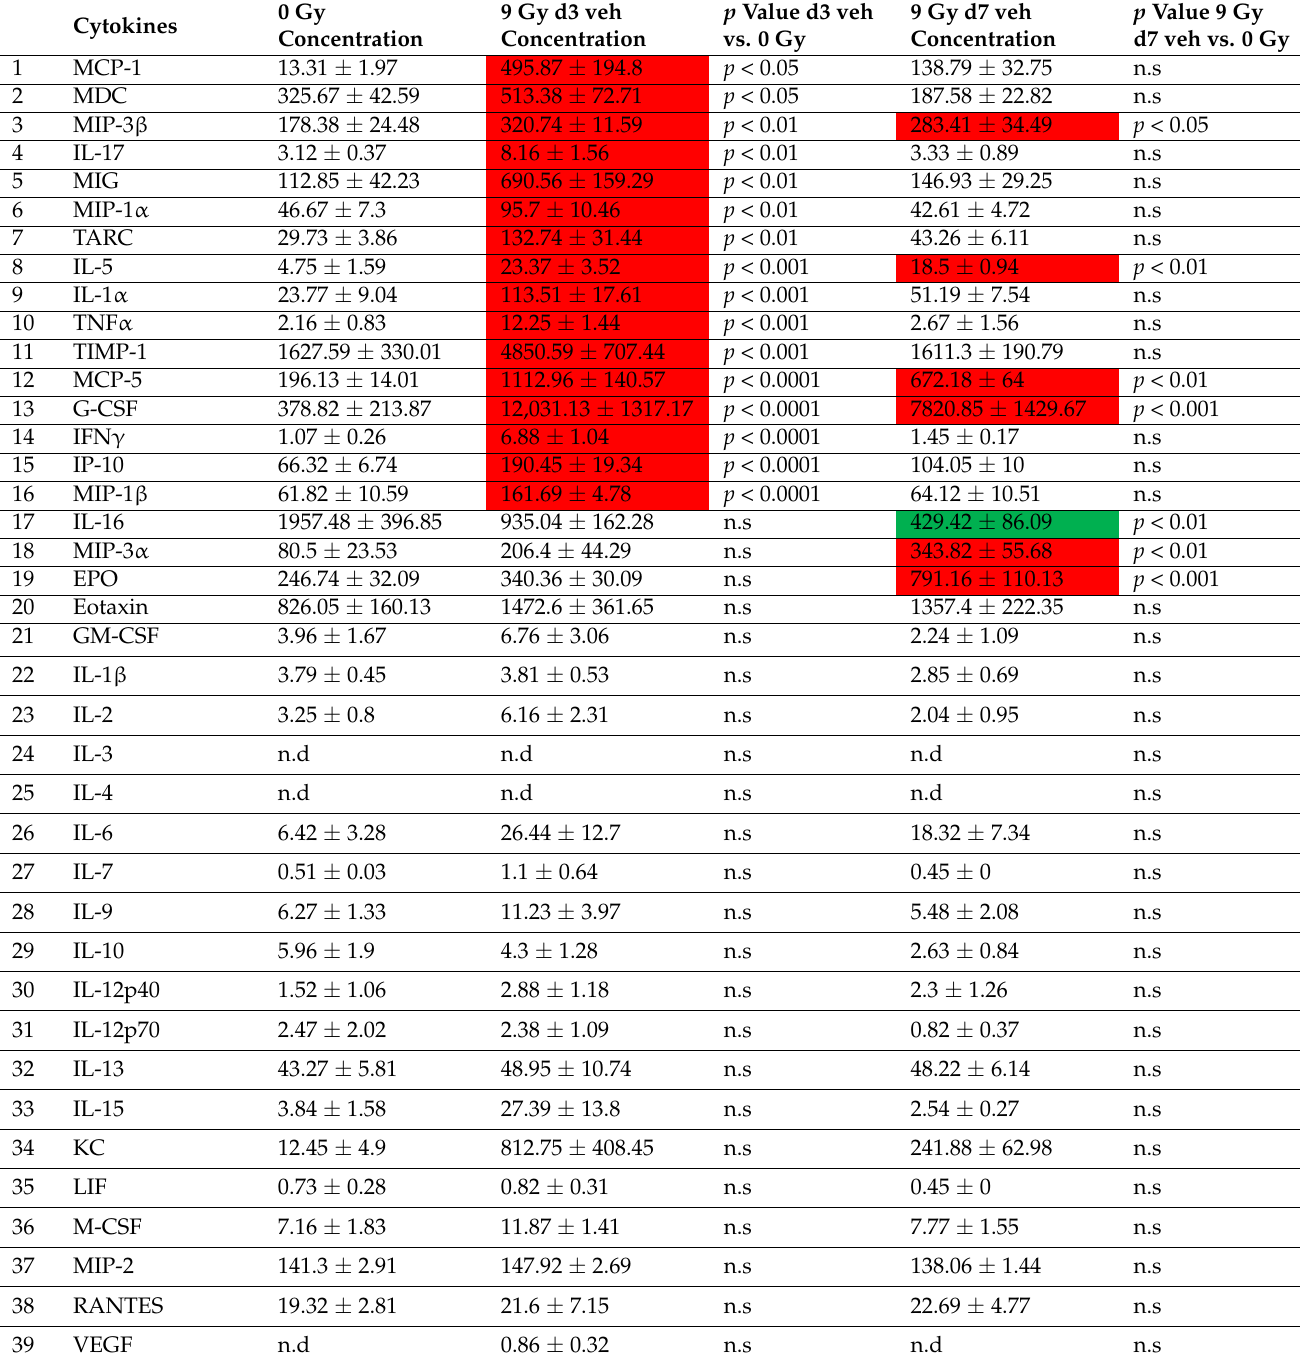
Table 1. Individual serum cytokine changes after 9.0 Gy TBI in CD2F1 male mice. Serum cytokine levels at d3 and d7 after irradiation with vehicle treatment were compared to the 0 Gy controls. All cytokines’ concentration unit was pg/mL. Mean ± standard error of mean (SEM) were shown for each cytokine. Red color represented significantly elevated cytokines and green color represented significantly decreased cytokines compared to 0 Gy controls. n.d, non-detectable. a.d, above detection. n.s, non significant. N = 5–6 mice/group. p < 0.05 is considered significantly changed. Mouse serum cytokine changes after 9